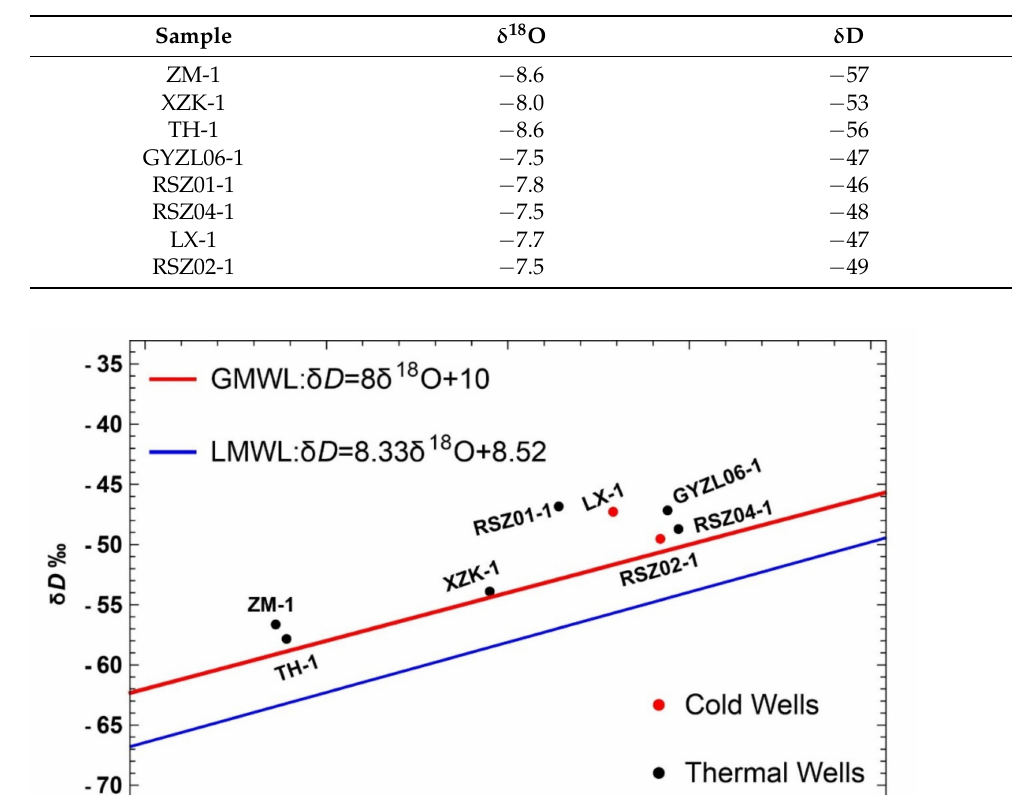
Table 3. Stable environmental isotopes (H and O) for thermal and cold wells expressed in ‰.